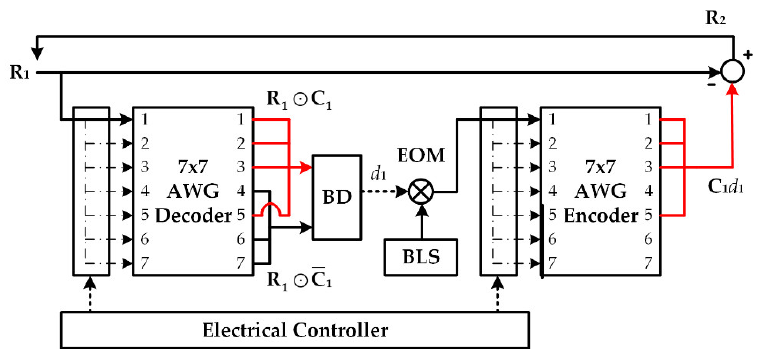
Figure 4. Receiver architecture designed with recursive interference cancellation (RIC).